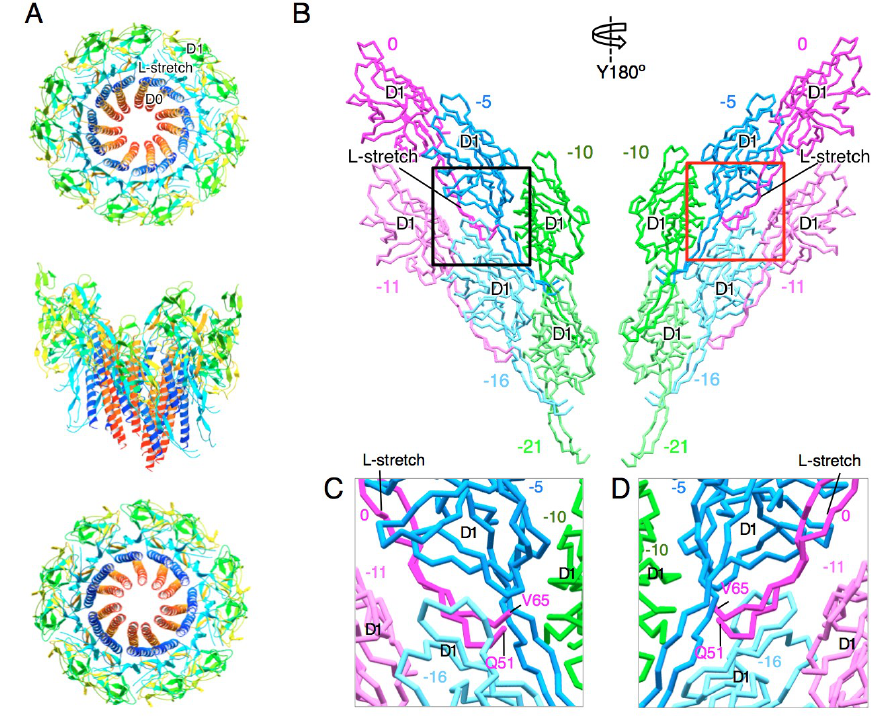
Figure 2. Structure model of the rod. ( A ) Two turns of the distal rod model. Eleven FlgG subunits along the one start helix are shown. Each subunit is colored from blue to red through the rainbow spectrum from the N to C terminus. Upper panel, viewed from the distal end; middle panel, side view; lower panel, viewed from the proximal end. ( B ) Subunit interaction of the D1 domain and the L-stretch in the rod. Six subunits in three adjacent protofilaments (two subunits from each protofilament) are shown. The number counted from the subunit 0 along the 1-start helical line is shown above or below each subunit. Left panel, view from the outside; right panel, view from the inside of the rod. ( C ) ( D ) Close up view of the L-stretch of the rod. The region in the black and red boxes in ( B ) are shown in ( C ) and ( D ), respectively. The tip of the L-stretch (P52-S64) is invisible due to poor density. Molecular figures were drawn using MolFeat (Ver 3.6, FiatLux